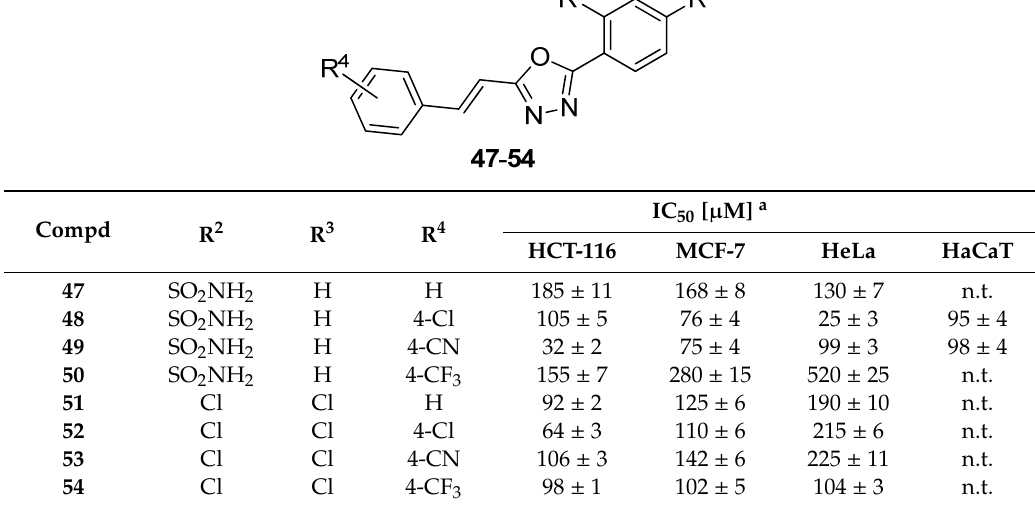
Table 2. Cytotoxicity of compounds 47 – 54 .